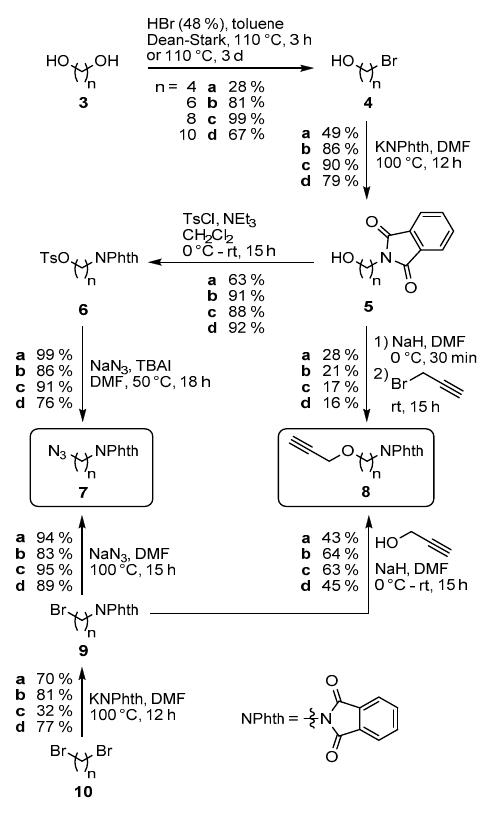
Scheme 1. Synthesis of triazole precursors 7 and 8 by different synthetic